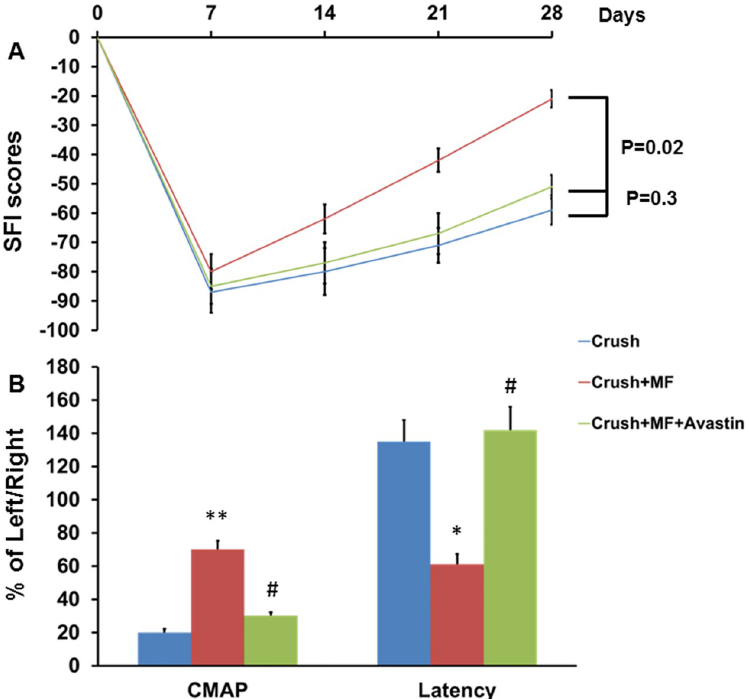
Fig 4. Representative SFI and electrophysiology results. There were three groups of animals subjected to SFI analysis weekly and then electrophysiology 4 weeks after injury. (A) The data of SFI related to different time points in the three different groups (B) CMAP and conduction latency presented as the ratio of left side/right side. Crush, Crush+MF, Crush+MF+Avastin: see text. � p < 0.05, �� p < 0.01 indicated the Crush+MF related to Crush, # p < 0.05 indicated Crush +MF+Avastin related to Crush+MF.